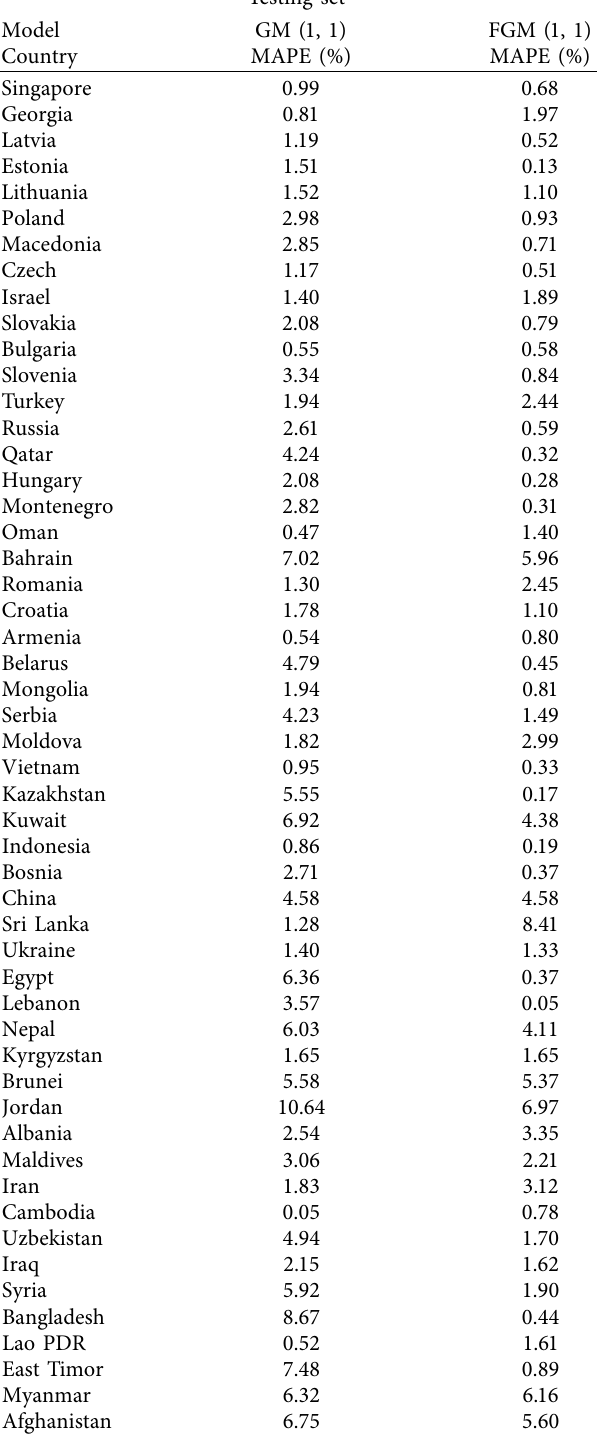
Table 5: MAPE values of the testing set. Testing